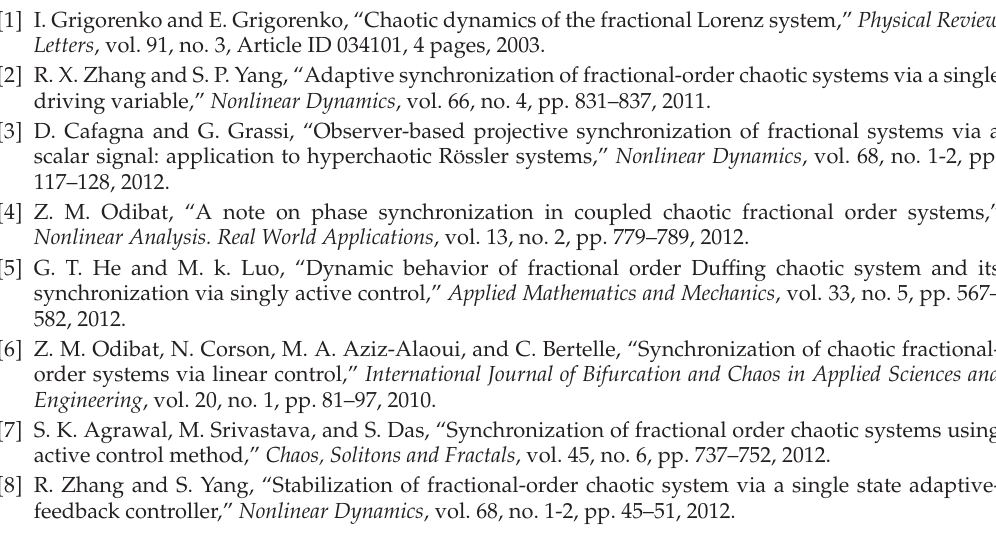
rigorous. Numerical simulations are used to illustrate the e ff ectiveness of the proposed synchronization